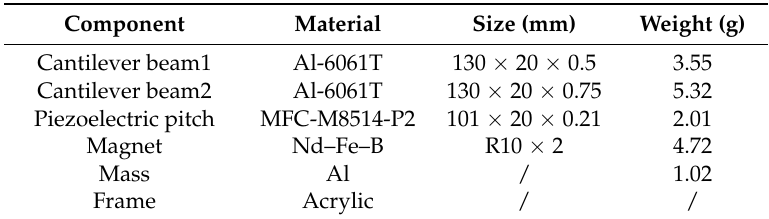
Table 3. Parameters of the prototype.